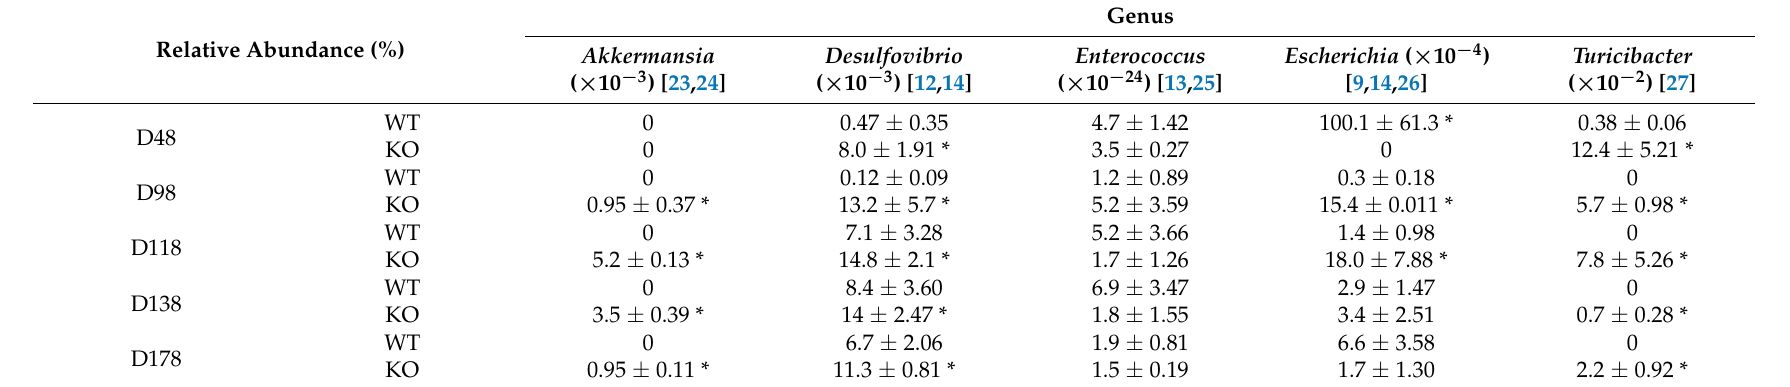
Table 2. Relative abundance of potential